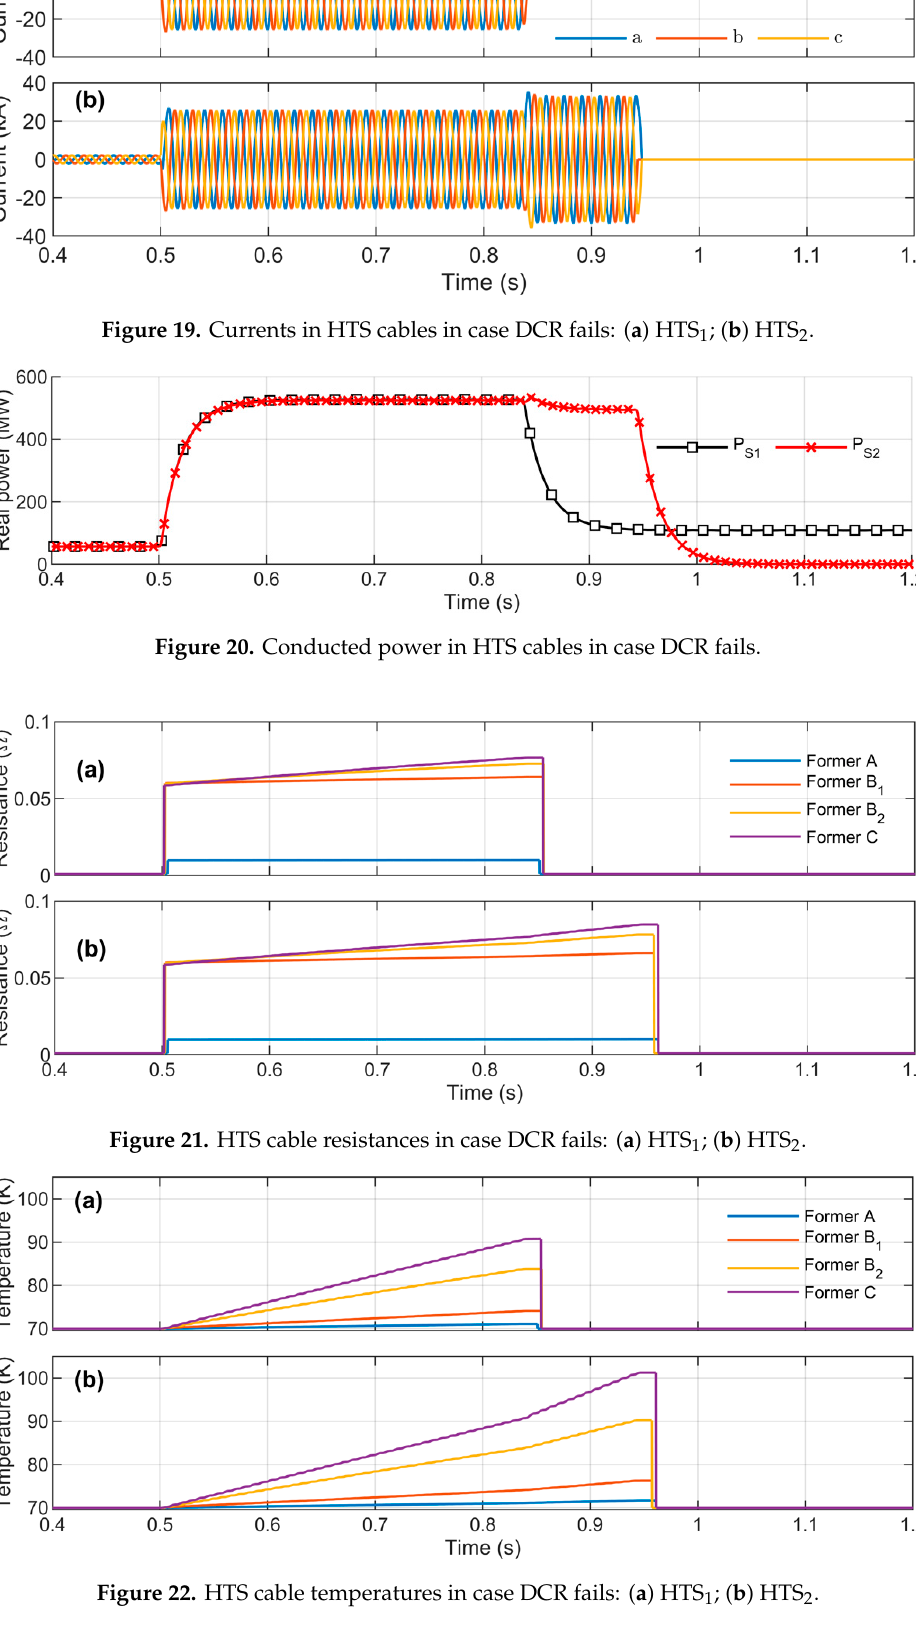
Figure 22. HTS cable temperatures in case DCR fails: ( a ) HTS 1 ; ( b ) HTS 2 .